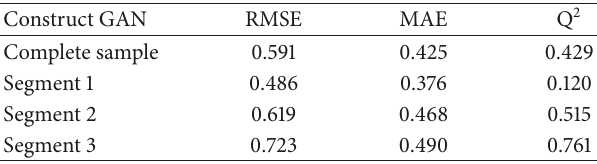
Table 10: Summary of dependent variable prediction. Construct GAN